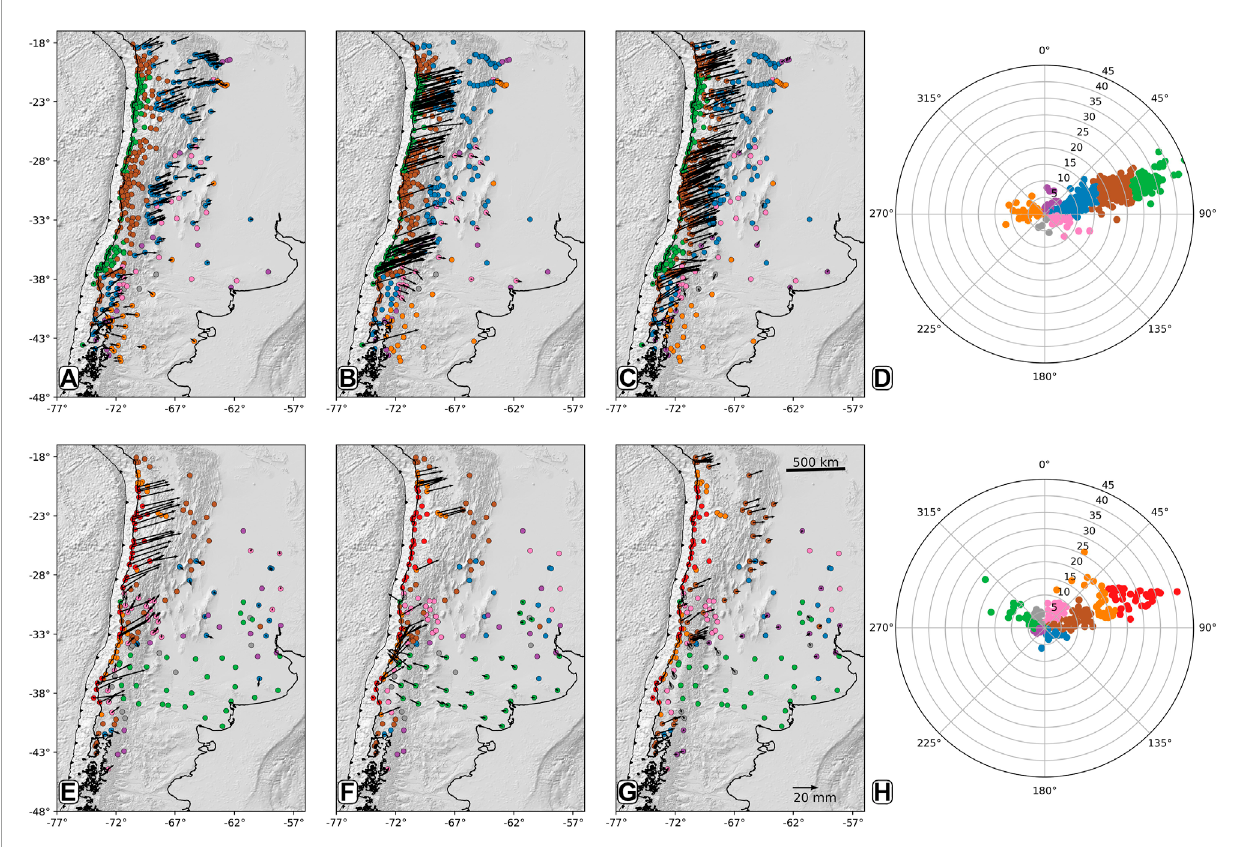
FIGURE 4 Velocity clustering results for the period pre-2014 with k = 7 (A–C) and the period 2018–2021 with k = 8 (E–G) , and their respective polar representations (D,H) .